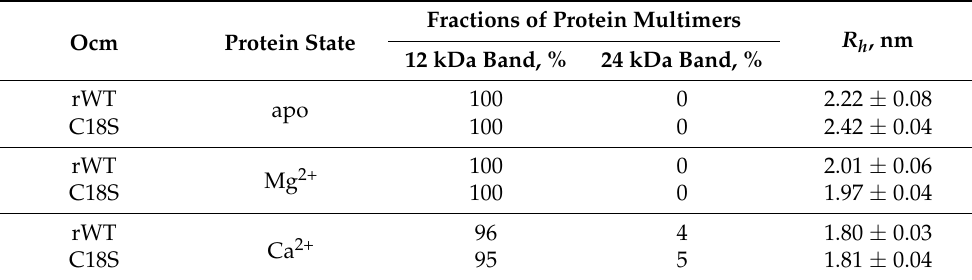
Table 2. Study of quaternary structure of rWT/C18S Ocm at 20 ◦ C according to chemical cross- linking with 0.02% glutaric aldehyde and DLS data (mean hydrodynamic radius, R h ); 1.3–1.7